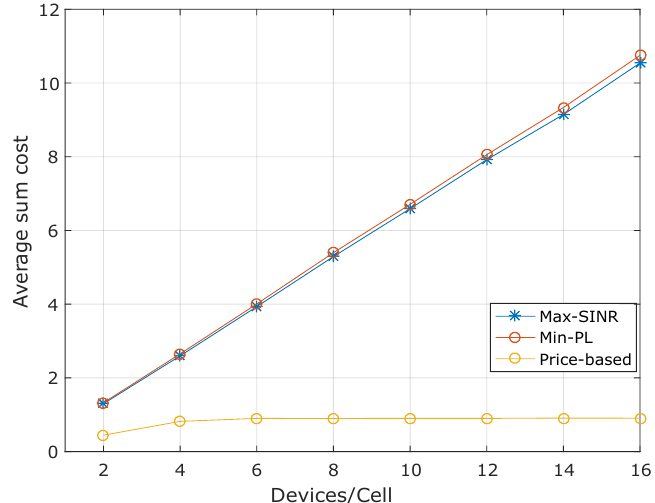
Figure 6. Average sum cost observed at the BSs as a result of the BS assignment solution found by each algorithm. The R min c requirement was set to 250 kbps for HTC devices and R min MTC